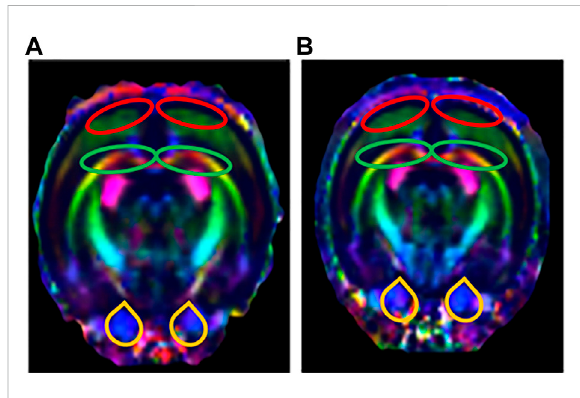
FIGURE 7 Tracing of nerve fi bers ( n = 6). The direction of travel: blue, rostral to caudal; Green, dorsal and ventral; Red, left and right. (A) Tracing of nerve fi bers in the control group. (B) Tracing of nerve fi bers in the LPS-4 d group. The red outlines indicated the prefrontal cortex (PFC), the green outlines indicated the hippocampus (HIP), and the yellow outlines indicated the ventral tegmental area (VTA).